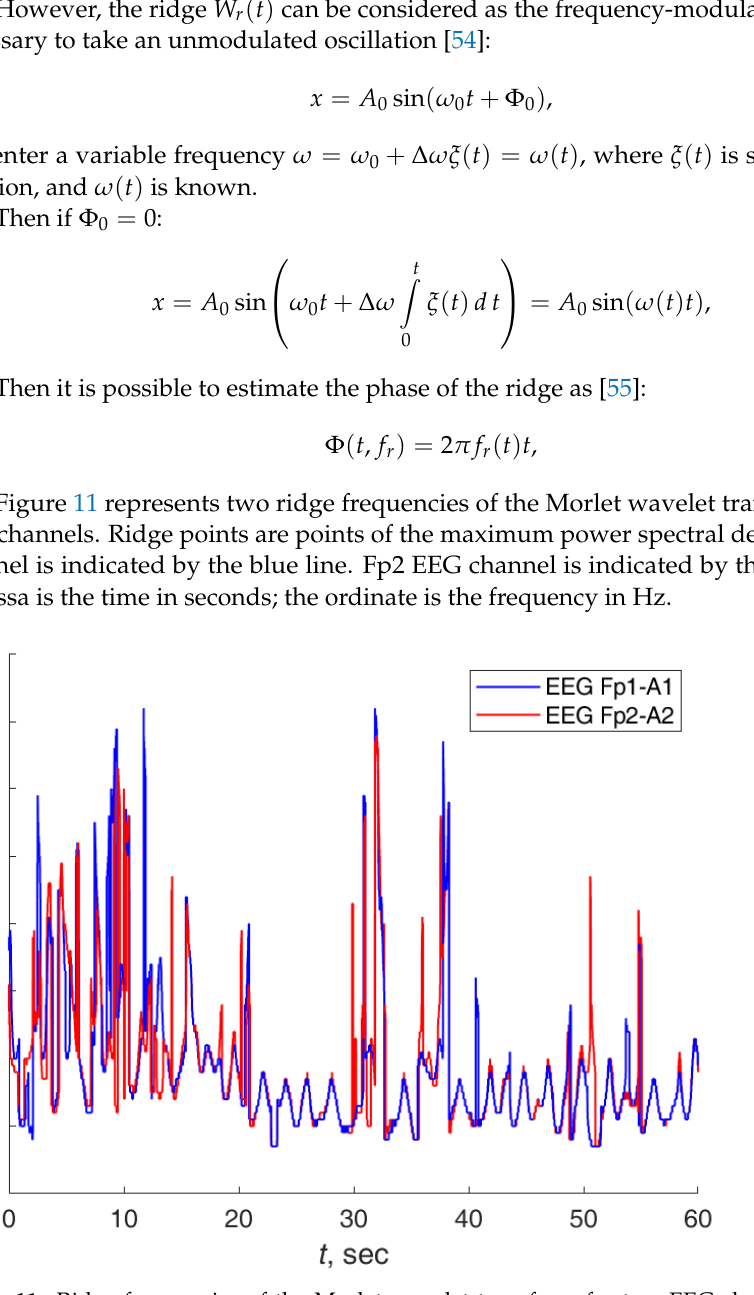
Figure 11. Ridge frequencies of the Morlet wavelet transform for two EEG channels. Fp1 EEG channel is indicated by the blue line. Fp2 EEG channel is indicated by the red